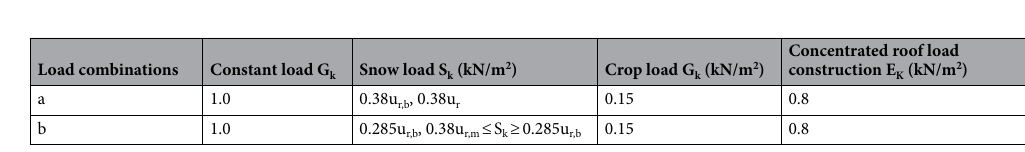
Table 4. The greenhouse skeleton load combination